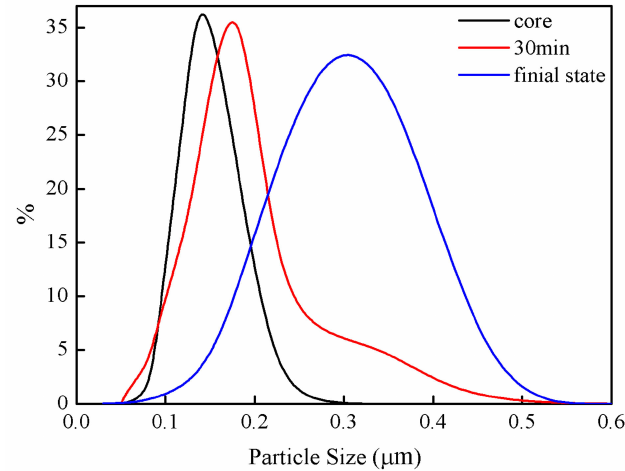
Figure 4. Particle size and its distribution of PVAc-AN/PS latex particles.